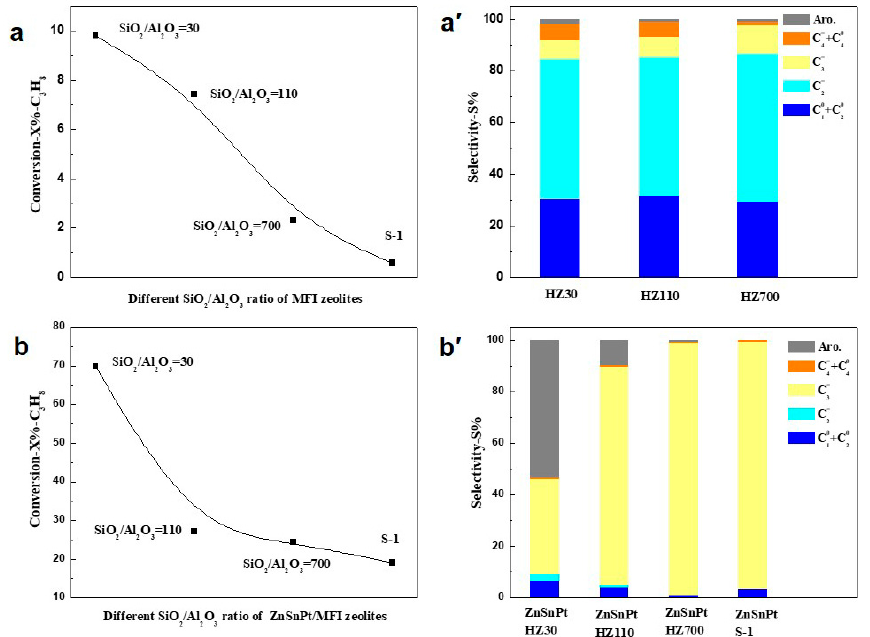
Figure 7. The performance of defective MFI zeolites ( a , a ′ ) and Zn-Sn-Pt modified defective MFI zeolites ( b , b ′ ) with different SiO 2 /Al 2 O 3 ratios in propane transformation with a fixed-bed reactor. (T = 610 °C, GHSV = 1800 h -1 , atmospheric pressure.).